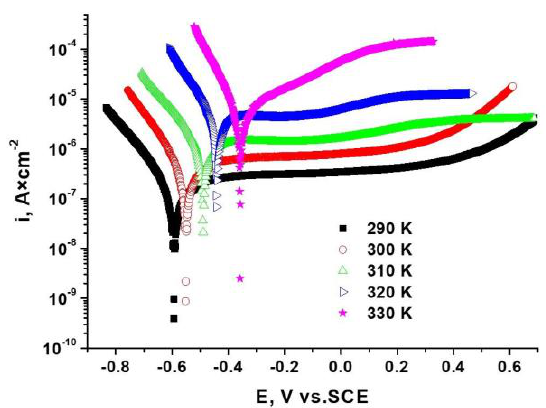
Figure 6. Polarization curves for CoCr alloy at different temperatures of artificial saliva.